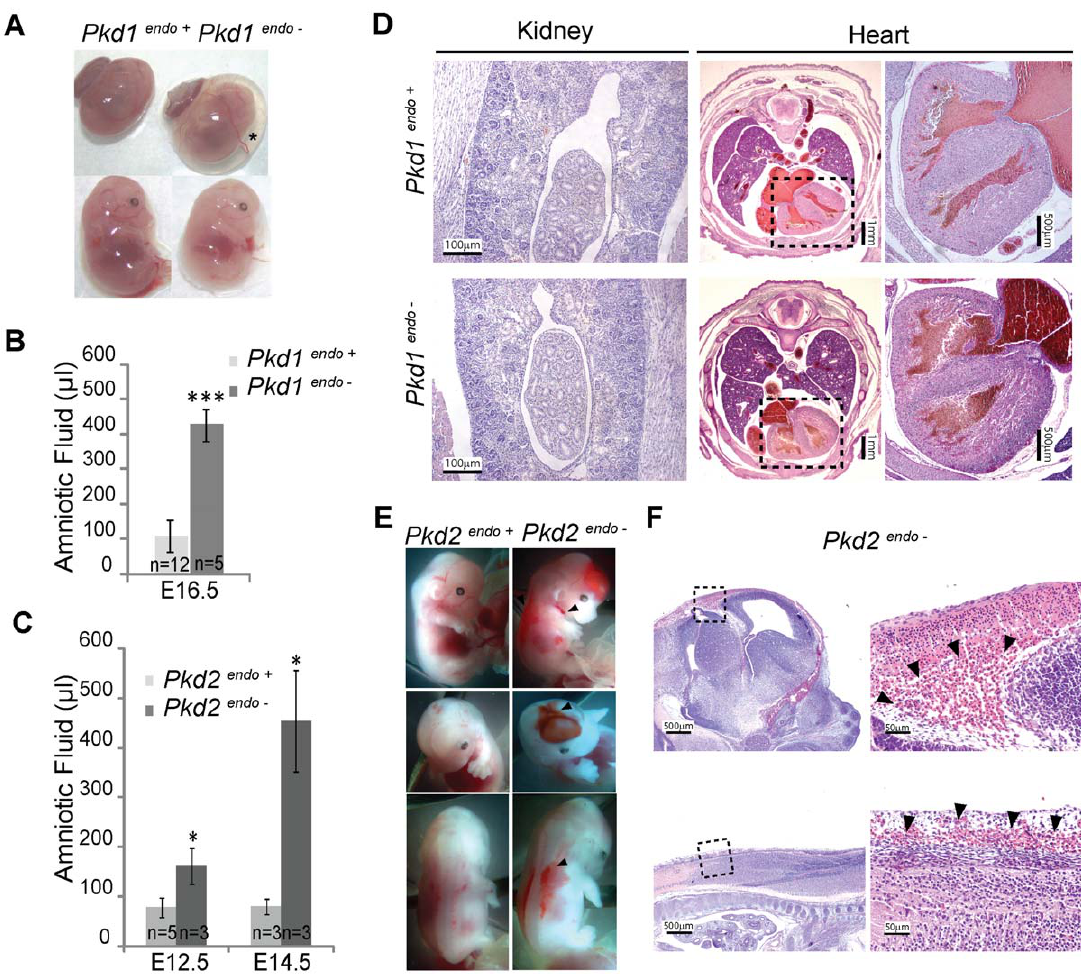
Figure 6. Phenotypes Associated with Endothelial cell loss of Polycystin 1 or 2. A. Gross appearance of E14.5 Pkd1 endo 2 (right) and littermate control (left). The Tie2-Cre + ( Pkd1 endo 2 ) embryo has polyhydramnios indicated by the asterisk. In the lower panel the yolk sac was removed and neither embryo has edema. B, C. Quantification of Amniotic Fluid demonstrates that both Pkd1 endo 2 (B) and Pkd2 endo 2 (C) embryos have significant polyhydramnios, *p , .05; *** p , .001. D. Haematoxylin-eosin staining of kidney and heart from an E16.5 Pkd1 endo 2 embryo and control. There are no obvious abnormalities in the Pkd1 endo 2 embryos. E. Gross appearance of an E14.5 Pkd2 endo 2 embryo with multiple areas of hemorrhage (right). A littermate control is also shown (left). Arrowheads indicate areas of hemorrhage. F. Haematoxylin-eosin staining of hemorrhagic areas in the head (upper panel) and back (lower panel). High power view of areas in dotted square shown at right. Arrowheads indicate free red blood cells.